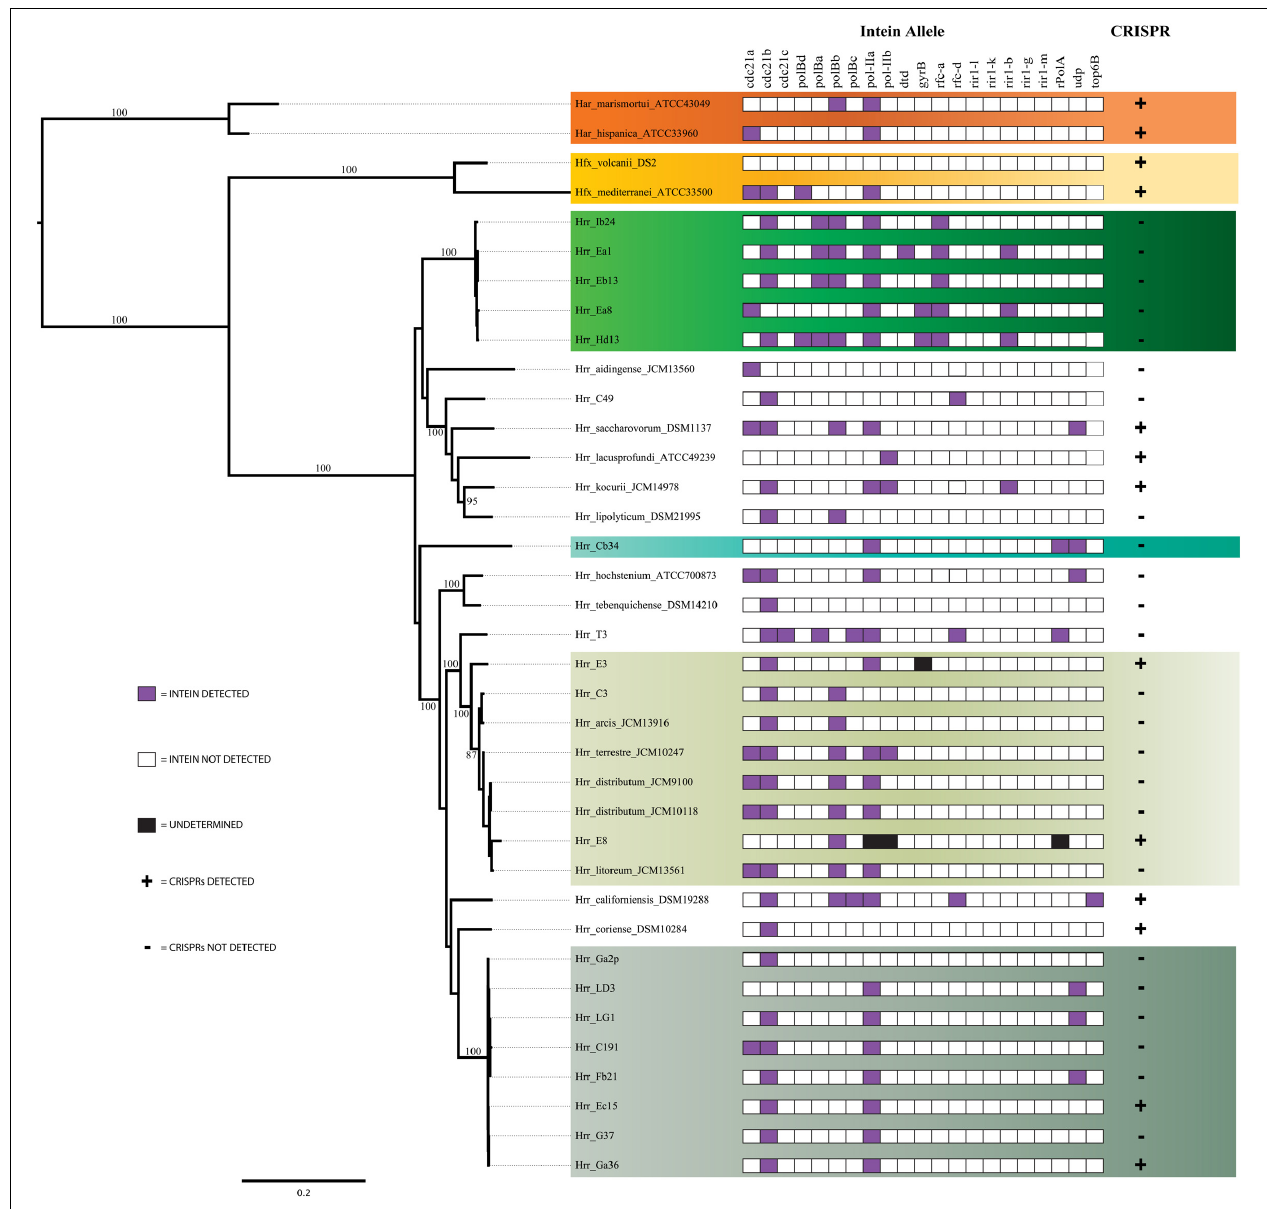
FIGURE 5 | Assessment of the presence of inteins and Clustered Regularly Interspaced Short Palindromic Repeats (CRISPRs). For inteins, purple boxes indicates the presence of an intein allele, white indicates its